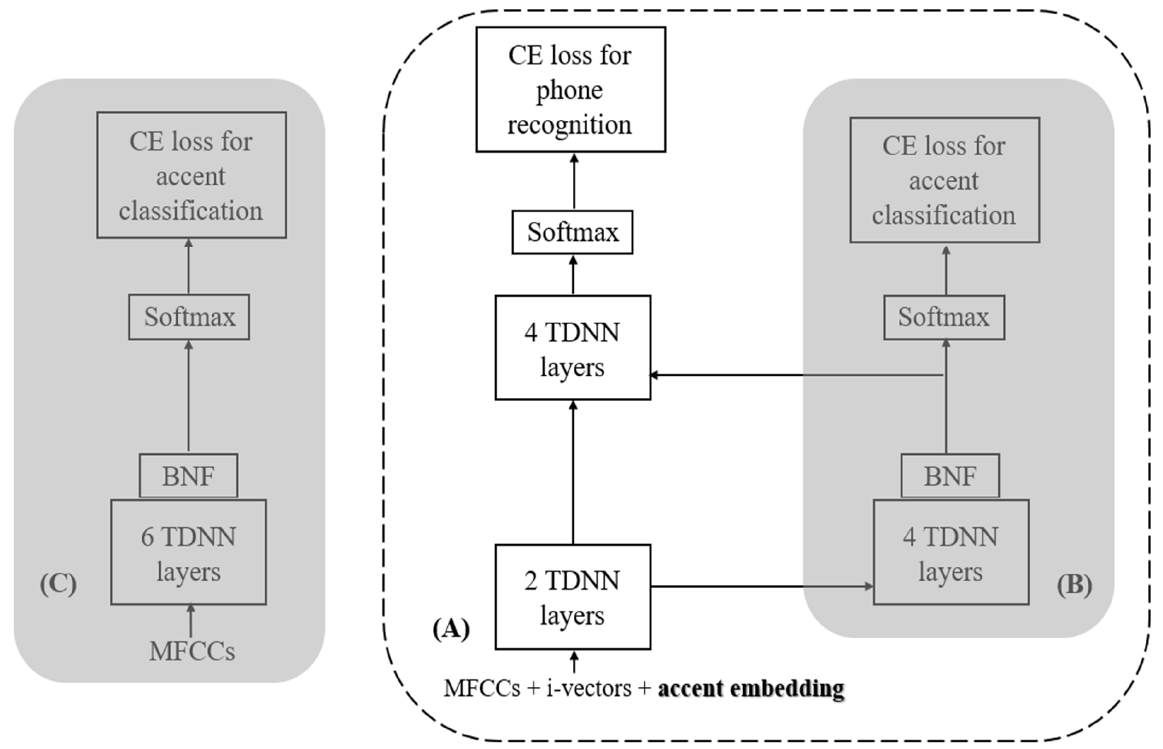
Figure 1. Architecture of the multi-task learning network and the standalone network in the accent embedding method. ( A ) Acoustic model; ( B ) Accent classifier; ( C ) Standalone network.